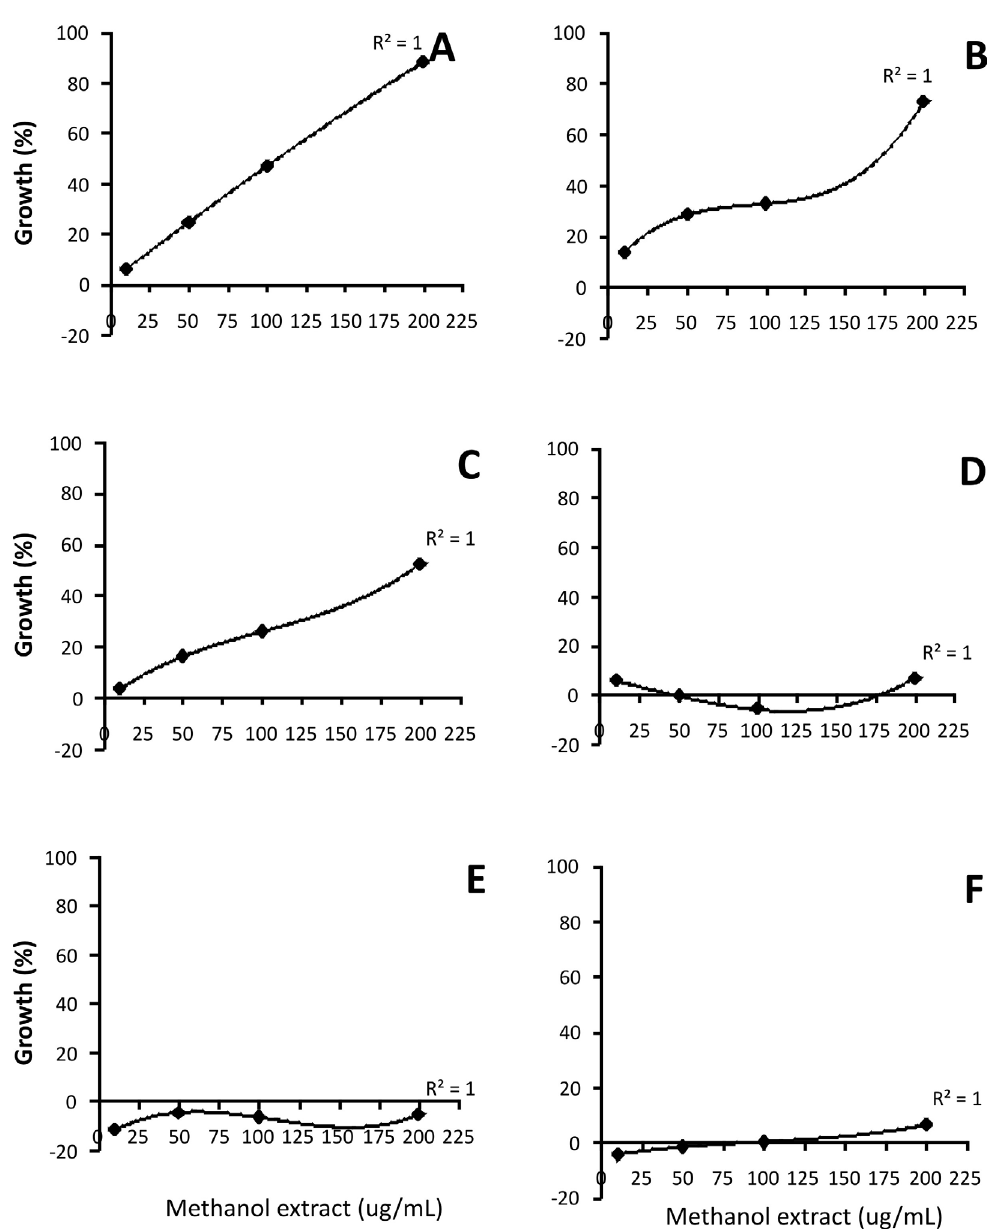
FIGURE 2 - Dose-response curve of methanol extracts from different medicinal plants in the proliferation assay with murine spleen cells for 72 hours at 37 °C and 5% CO . A: Calophyllum brasiliense ; B: Ipomea pes-caprae ; C: Matayba elaeagnoides ; 2 D: Maytenus robusta ; E: Rubus imperialis , F: Vernonia scorpioides ; R 2 : coefficient of determination. Results are presented as the mean of four experiments performed in